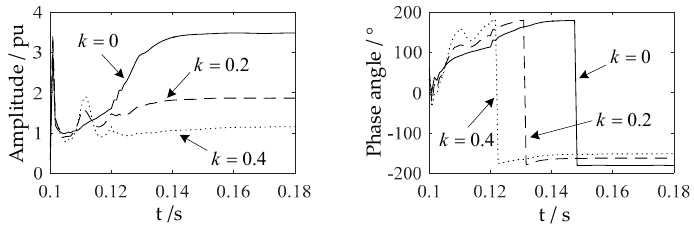
 Z in Case 1. in Case 1.  w +